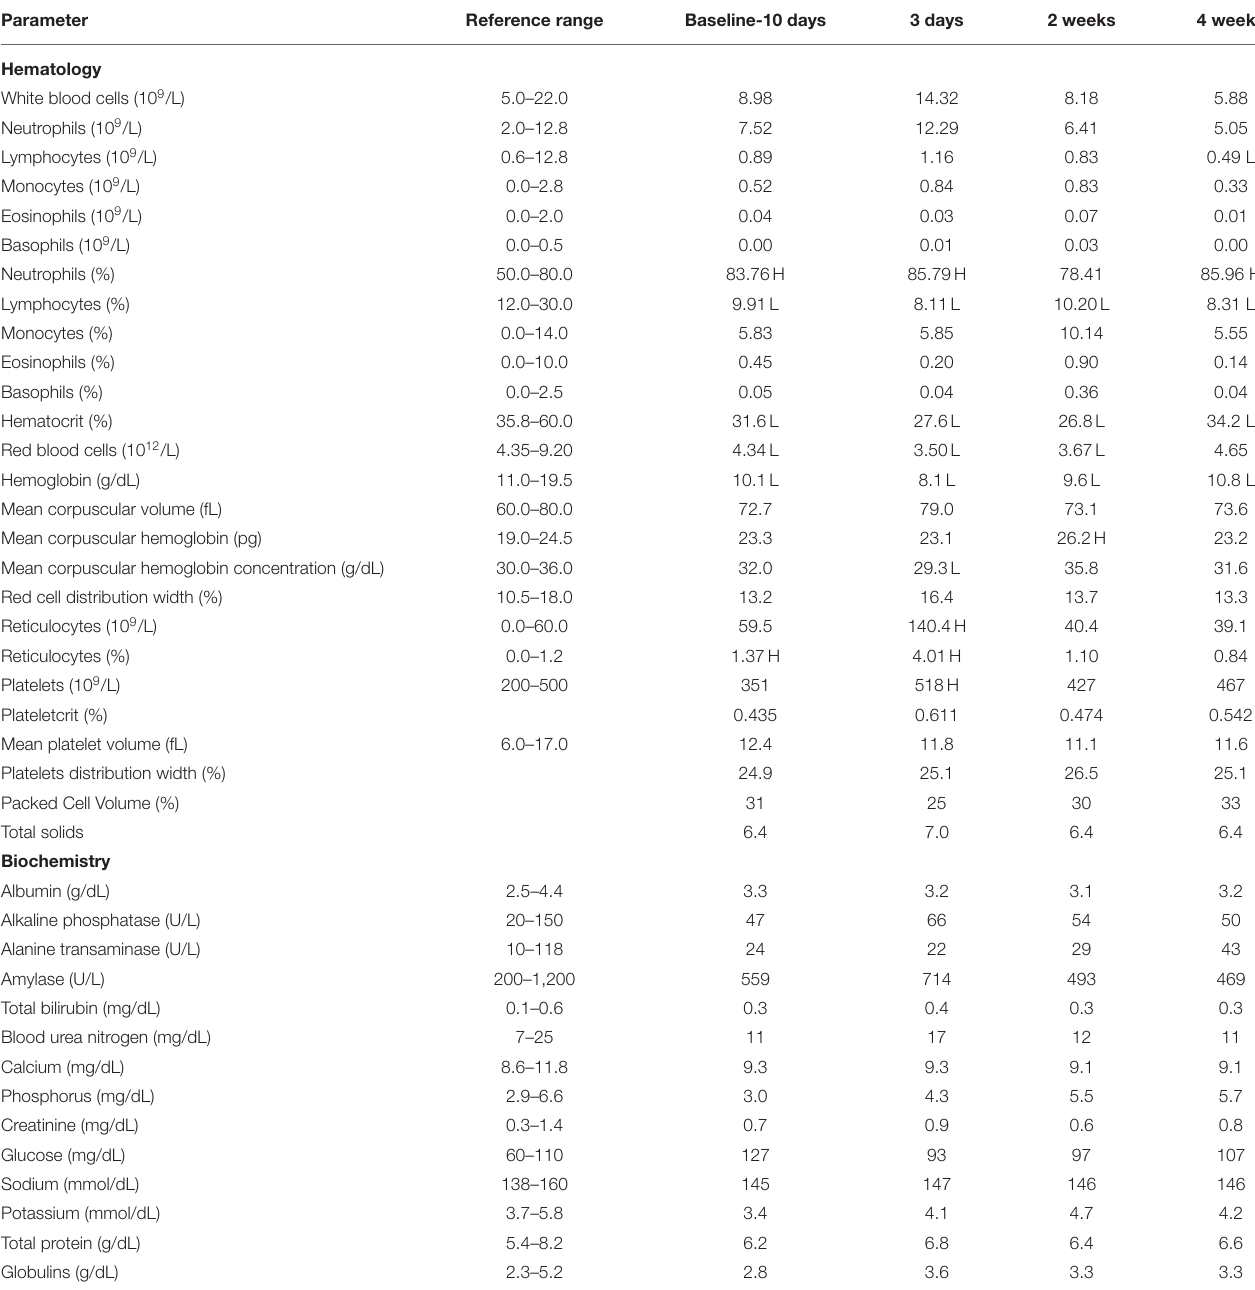
TABLE 2 | Complete blood count and biochemistry panel performed in a 14-year-old dog suffering from bilateral hip and elbow osteoarthritis and severe neck pain, before and after liposomal cannabidiol subcutaneous injection. Parameter Reference